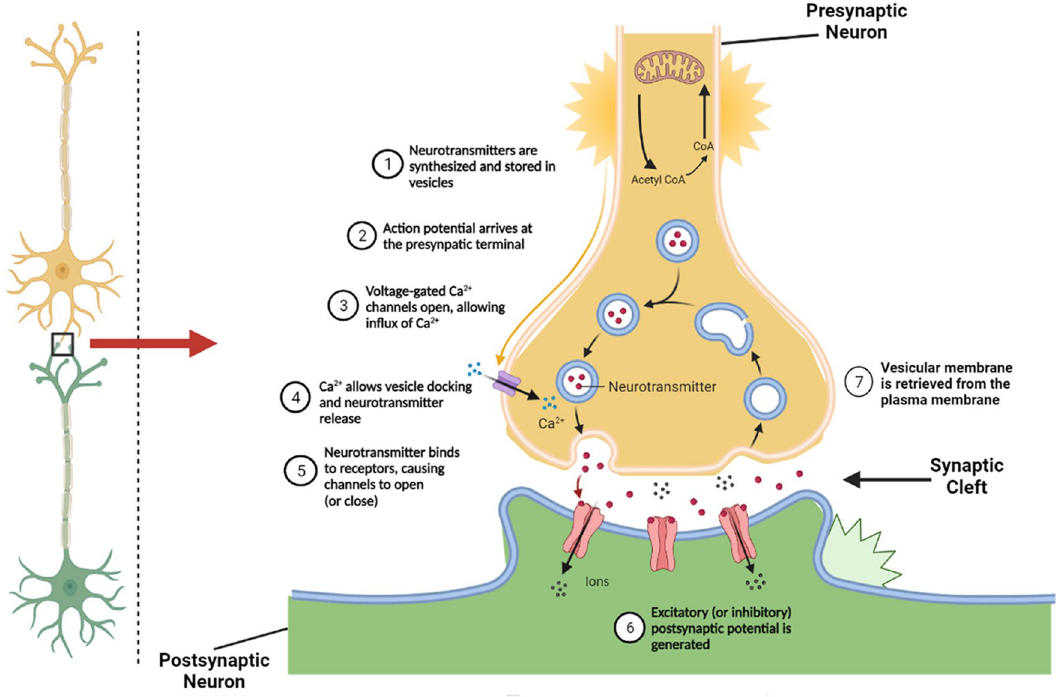
Figure 1. Synaptic pathways and role of Acetylcholine and Cholinesterase in a normal nerve cell (the figure was created with